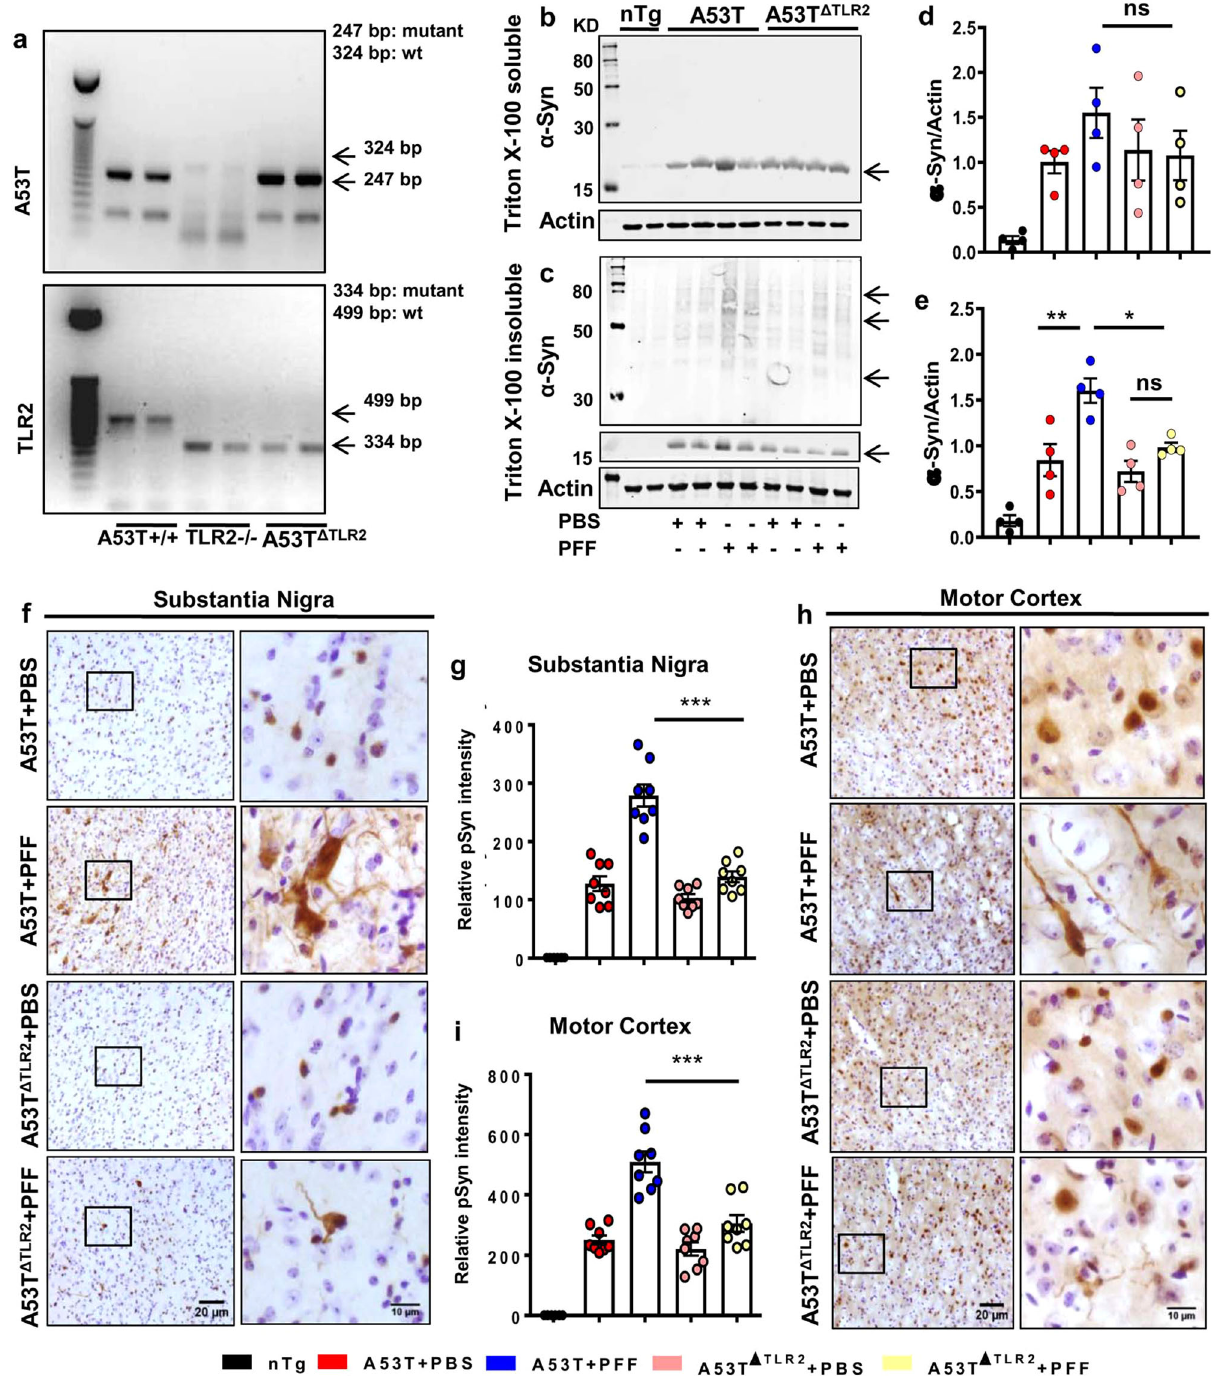
Fig. 3 The α -Syn spreading is reduced in PFF-seeded A53T mice lacking TLR2. A53T + / + mice were crossed with TLR2 − / − mice to generate A53T Δ TLR2 double transgenic mice. These mice were validated by genetic screening where 324 and 247 bp bands correspond to nTg and A53T Tg mice respectively (marked with arrows). Similarly, 499 and 334 bp bands indicate nTg and TLR2 − / − mice respectively (shown with arrows) ( a ). Spreading of α -syn in SN of PFF-seeded A53T and A53T Δ TLR2 mice was compared by assessing total α -syn level in Triton X-100 soluble ( b , d ) and insoluble ( c , e , p = 0.0027 for A53T + PBS vs A53T + PFF and p = 0.014 for A53T + PFF vs A53T Δ TLR2 + PFF ) fractions by immunoblotting. Actin was used as the loading control. Level of pSyn129 in SN ( f , g , p = 0.00015 for A53T + PFF vs A53T Δ TLR2 + PFF ) and motor cortex ( h , i , p = 0.0003 for A53T + PFF vs A53T Δ TLR2 + PFF ) was monitored by immunostaining ( f , h ) followed by pSyn129 intensity analysis using Fiji. Two sections from each brain were used for staining and individual values from each section are shown. Two-way ANOVA was performed to determine statistical signi fi cance among different groups. * p < 0.05, ** p < 0.01, and *** p < 0.001 indicate signi fi cance compared to respective groups. Values are given as mean ± SEM ( n = 4 animals per group).